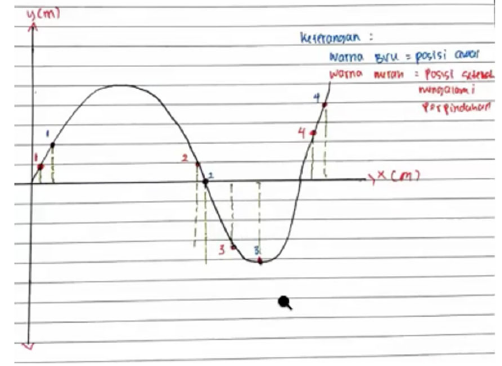
FIG. 8. Yuda ’ s difficulty drawing two wave profiles in one graph.